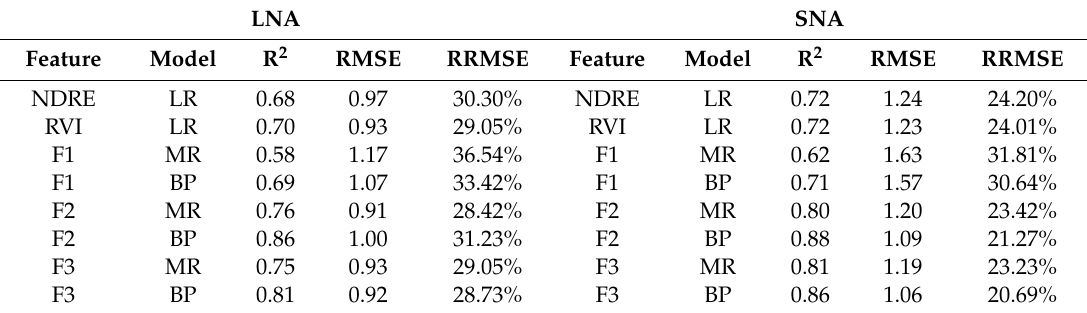
Table 4. Comparison of LNA and SNA estimates derived from di ff erent features in the late jointing stage. LNA SNA